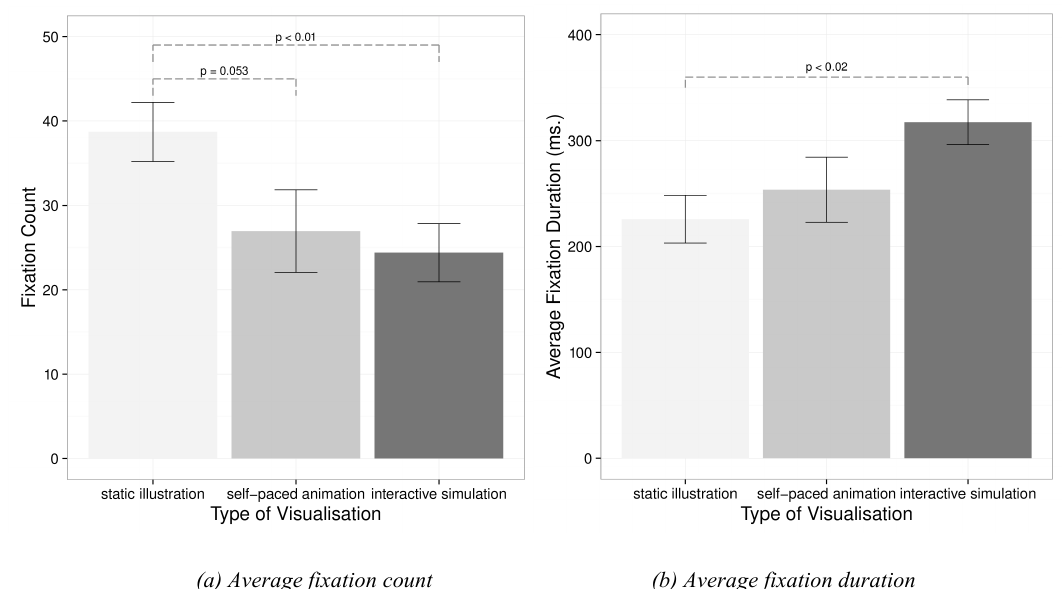
Figure 3. Fixation count and duration depending on visualization type. The whiskers represent